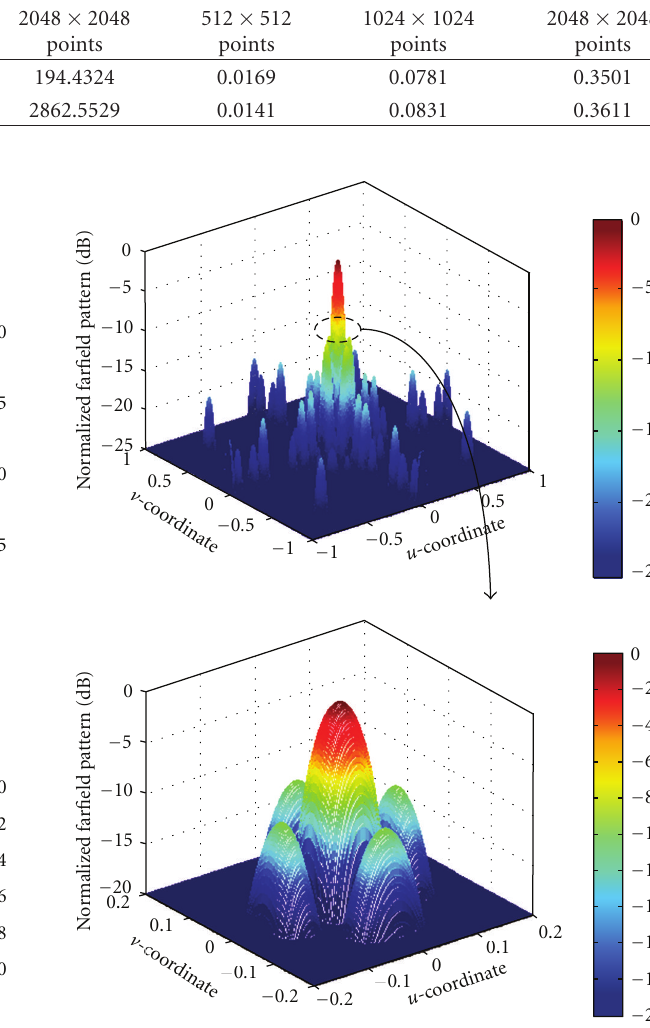
Figure 5: Radiation pattern of the optimized stage 3 Sierpinski carpet array.